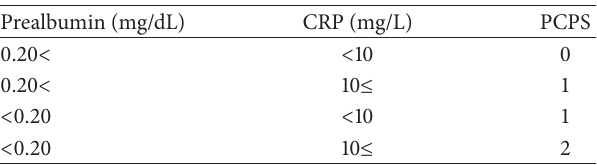
Table 2: Classification of prealbumin/CRP based prognostic score (PCPS).